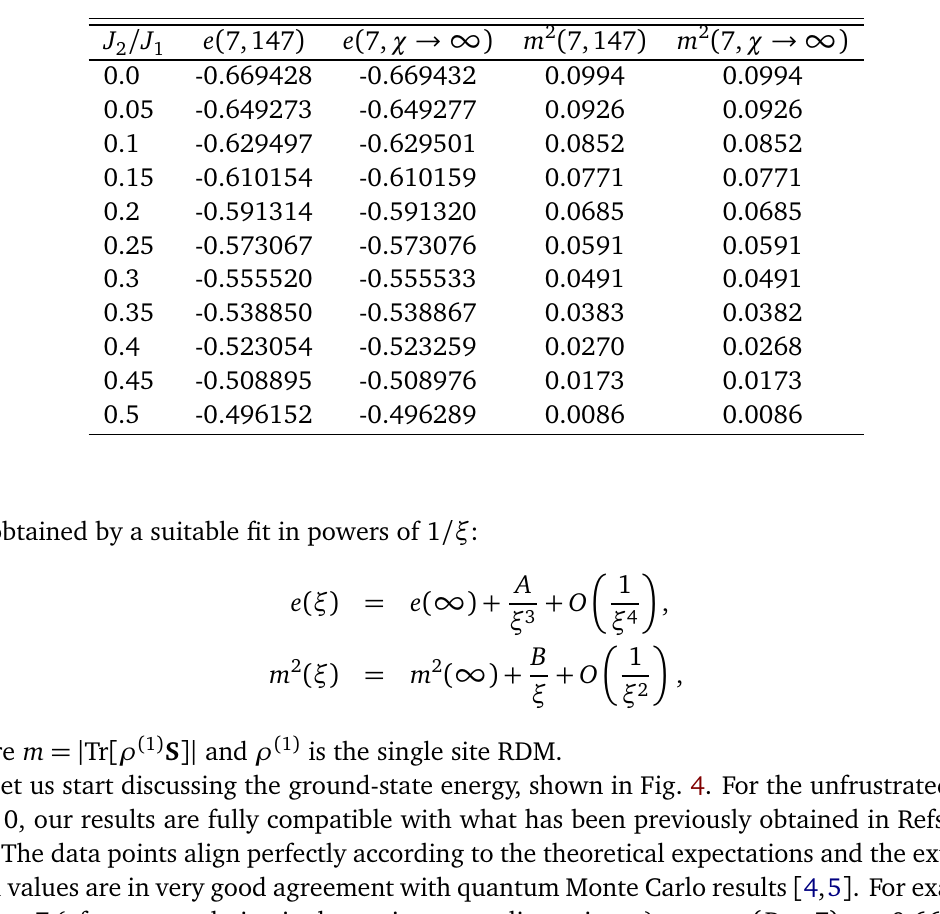
) e ( D , χ ) and magnetization square 1